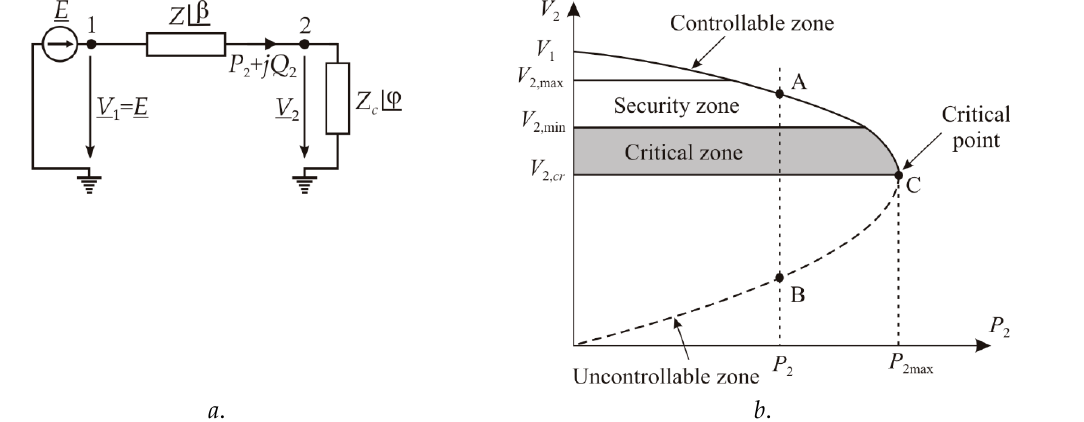
Figure 1. Simple one-line diagram ( a ); and the P - V characteristic ( b ).